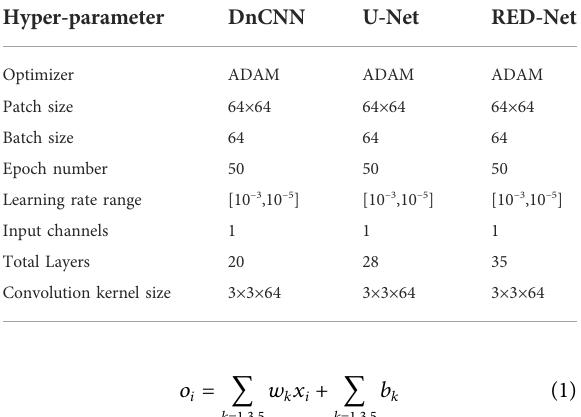
TABLE 3 Network parameters of DnCNN, U-Net and RED-Net.